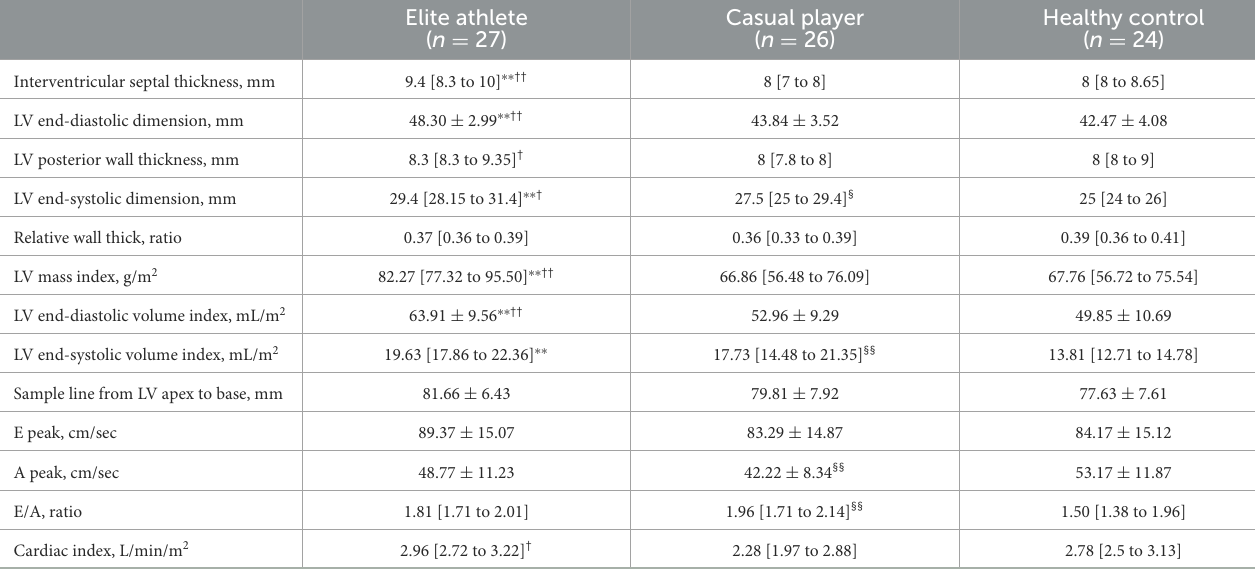
TABLE 2 Echocardiographic parameters in elite athletes, casual players, and healthy controls.